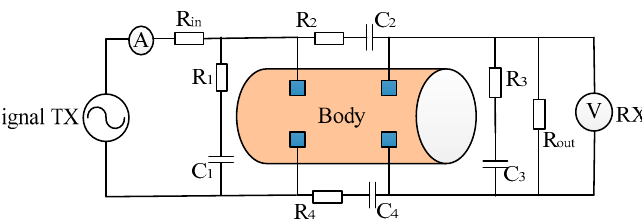
Figure 2. The field-circuit model of signal transmission path in the galvanic intra-body communication.